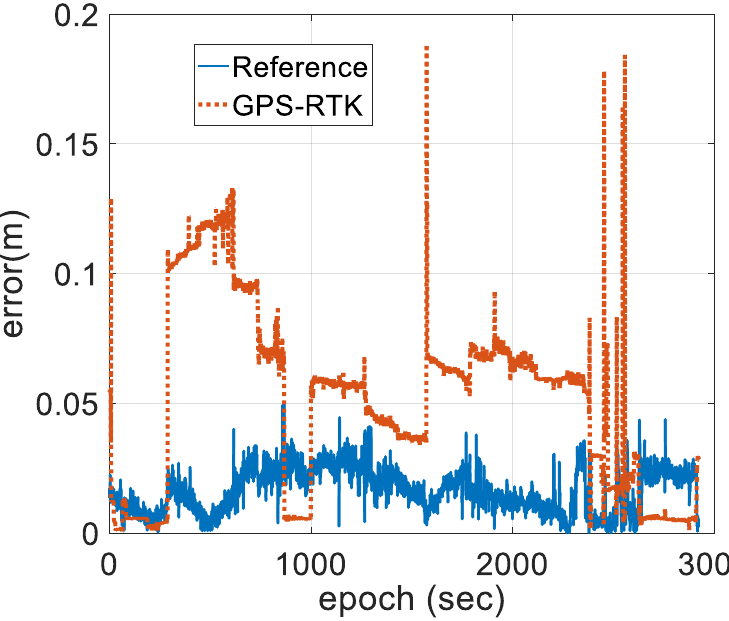
Figure 8. Two-antenna baseline length bias distribution.